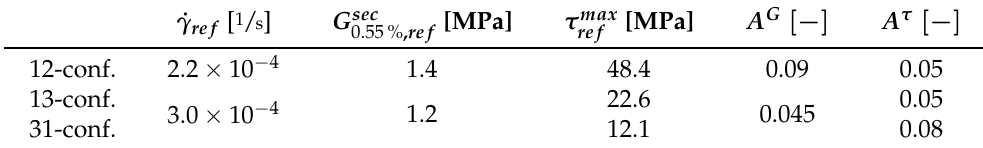
Table 3. Final material parameters for strain rate dependency—MaS